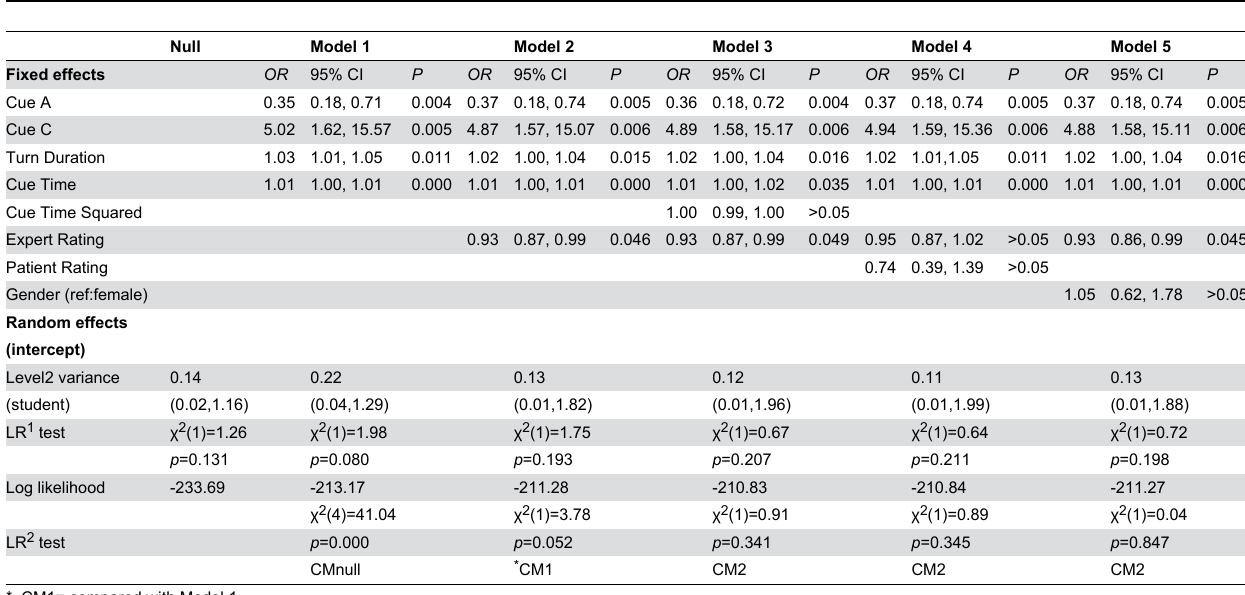
Table 4. Multilevel logistic regression lag 1 sequence models for reduce space